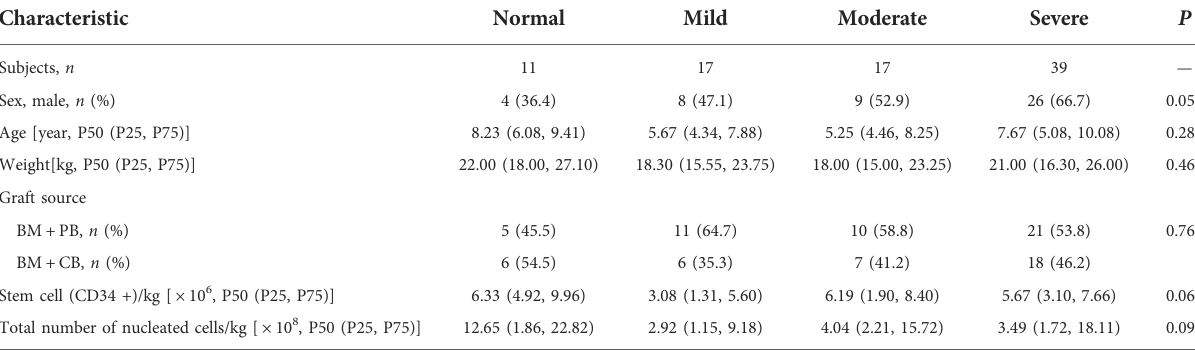
TABLE 1 Group characteristics ( n